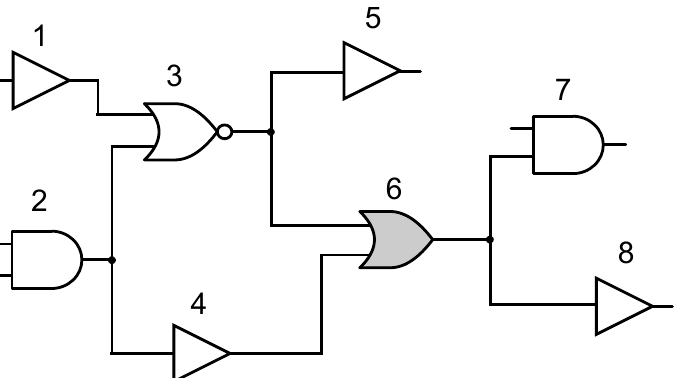
Figure 2. Example design to show which LMs are considered in computation of local cost and to present LM equalities to preserve optimality KKT conditions, which imply that sum of input LMs must be equal to sum of output LMs. Thus, for highlighted gate 6, LMs λ 13 , λ 23 , λ 24 , λ 35 , λ 36 , λ 46 , λ 67 and λ 68 multiplied with their corresponding delays will form local cost. For LM propagation, for gate 6, we should guarantee that λ 36 + λ 46 = λ 67 + λ 68 .